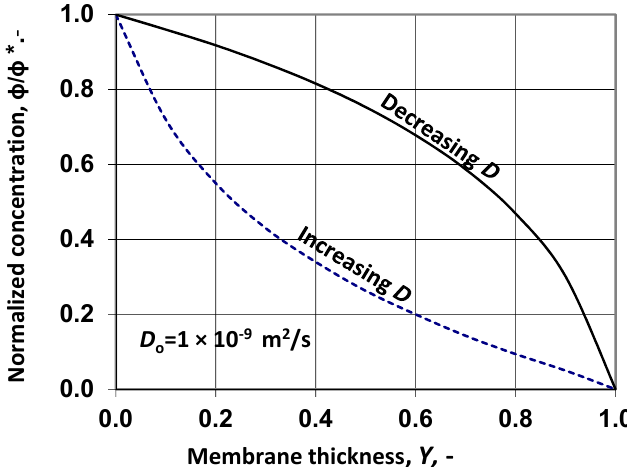
Figure 3. The concentration distribution during di ff usive mass transport in the case of a variable increasing ( D = D o (11 − 0.1( N − i )) or decreasing di ff usion coe ffi cient D = D o (1 + 0.1( N − i )) predicted Figure 2. The concentration distribution during diffusive mass transport in the case of a variable by the expression in Section 2.1; D o = 1 × 10 − 9 m 2 / s; N = 100; k o = 1 × 10 − 5 m / s; δ = 1 × 10 − 4 m; note the increasing ( D = D o (11 − 0.1( N − i )) or decreasing diffusion coefficient D = D o (1 + 0.1( N − i )) predicted by membrane thickness means the value of ( Y = y / δ ), for all cases the expression in Section 2.1; D o = 1 × 10 − 9 m 2 /s; N = 100; k o = 1 × 10 − 5 m/s; δ = 1 × 10 − 4 m; note the membrane thickness means the value of ( Y = y / δ ), for all cases plotted).